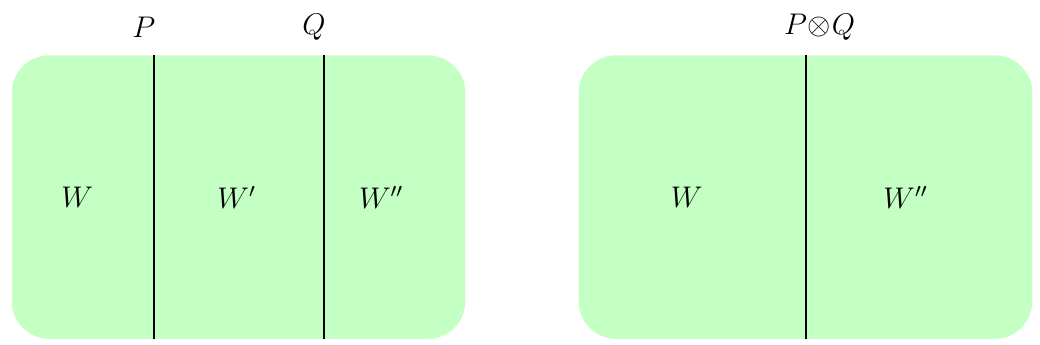
Figure 2 . The fusion of the interfaces described by P and Q leads to a new interface described by the tensor product P ⊗ Q . The theory with superpotential W 0 disappears in this